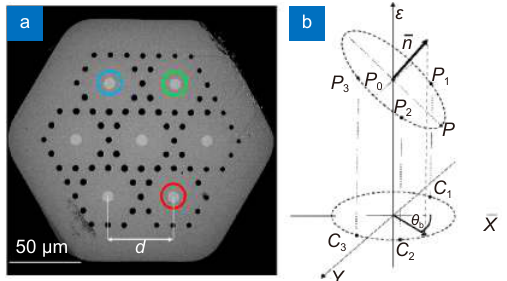
Fig. 16 | ( a ) Cross section of the MCF. The circled fiber cores were selected for bending direction analysis. ( b ) Fiber bending direction analysis in the x - y - ε space. The x - y plane corresponds to one cross section of the MCF. Figure reproduced from ref. 181 , under the OSA Open Access Publishing Agreement.